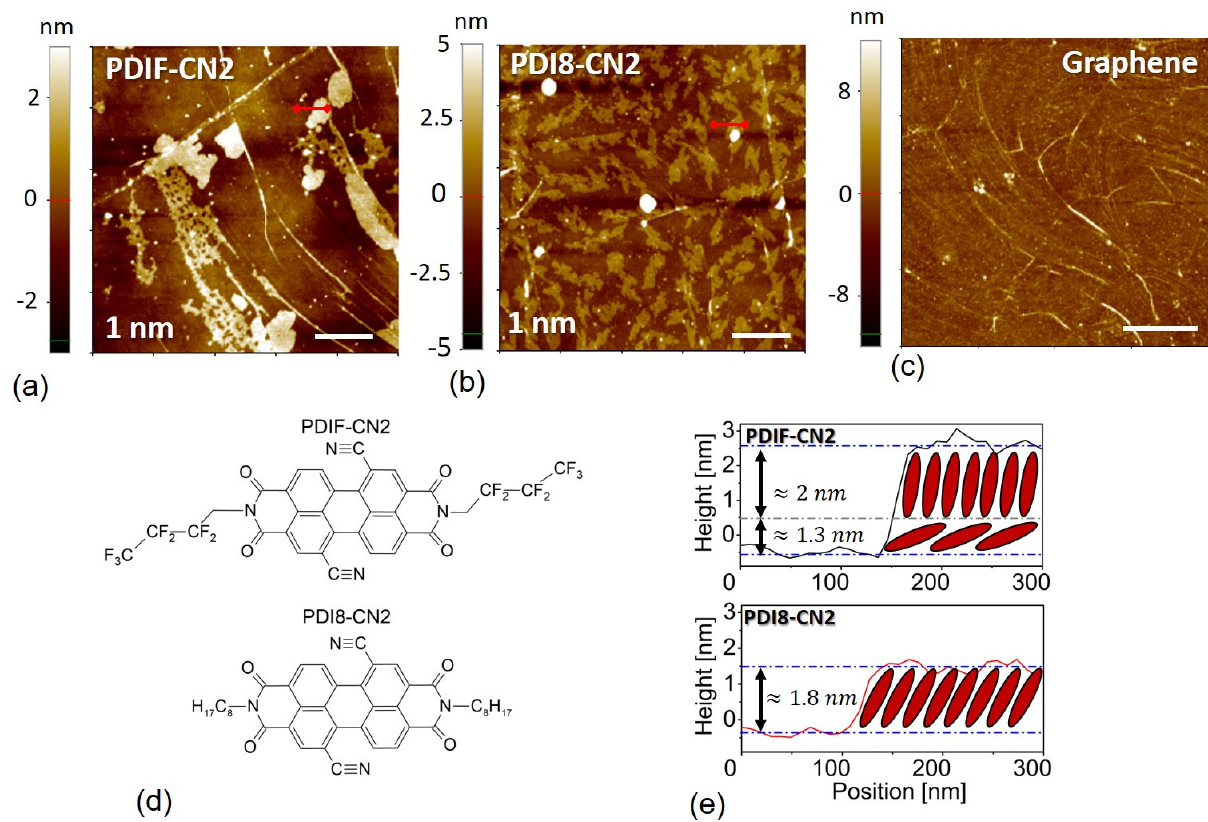
Figure 1. ( a , b ) The 5 nm × 5 nm NC-AFM topographies of the PDIF-CN2 and PDI8-CN2 sub- monolayers with nominal thicknesses of 1 nm, grown on the graphene surfaces. The white bars in the panels set a 1 nm reference. ( c ) Bare CVD-graphene surface as reference (10 µm × 10 µm, white bar a 2.5 µm reference), highlighting the sparse presence of wrinkles. ( d ) Molecular structures of the two perylene diimides derivatives employed in this work. ( e ) Line profiles corresponding to the red lines in panels ( a ) and ( b ) for the two materials. It is easy to deduce a nearly face-down molecular wetting layer ( ≈ 1.3 nm) in the PDIF-CN2 case.